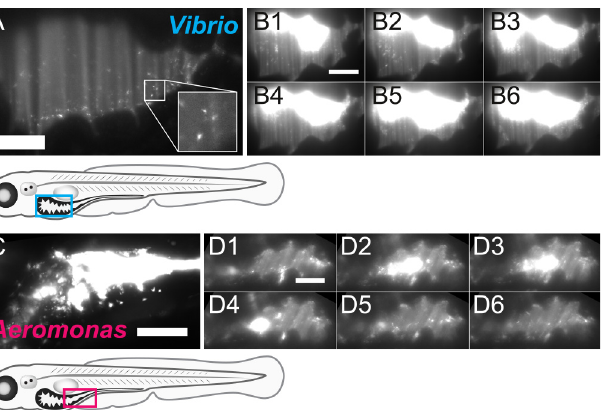
Fig 4. Populations of Vibrio and Aeromonas exhibit different dynamics within the zebrafish intestine. (A) An optical section of the intestinal bulb from a larval zebrafish mono-associated with Vibrio (the cyan box in the diagram below outlines the region imaged). The population consists of discrete, highly motile individuals (inset: single Vibrio cells). (B) A montage of images taken from the time-series in S3 Movie shows that the highly motile and planktonic Vibrio cells maintain their overall distribution despite repeated intestinal contractions. Time between frames: 1 second. (C) An optical section of the intestinal midgut from a larval zebrafish mono-associated with Aeromonas (the magenta box in the diagram below outlines the region imaged). Cells are largely non-motile and densely aggregated. (D) A montage of images taken from the time- series in S7 Movie shows an aggregate of Aeromonas in the midgut that is spatially dynamic, entering and exiting the field of view multiple times. Time between frames: 1 second. (A – D) Scale bars: 50 μ m.